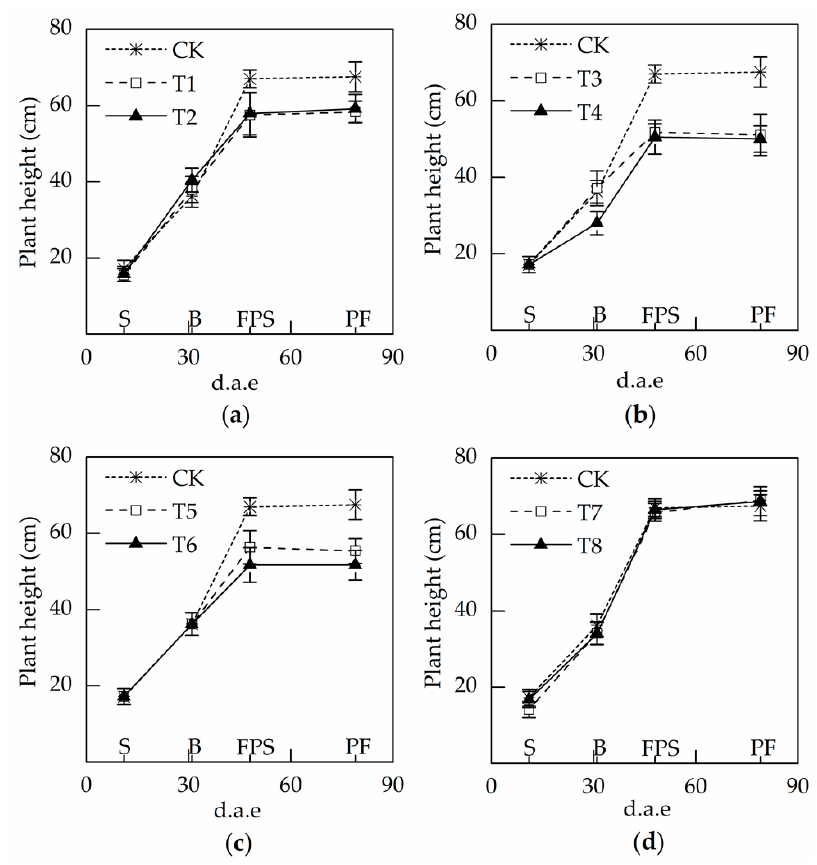
Figure 2. Plant heights of soybean during different growth stages under water stress in 2015: ( a – d ) the treatments with drought stress during seedling, branching, flowering and pod-setting stage, and pod-filling stage, respectively. S, seedling stage; B, branching stage; FPS, flowering and pod-setting stage; PF, pod-filling stage; d.a.e, day after emergence. Values were averaged from five samples.